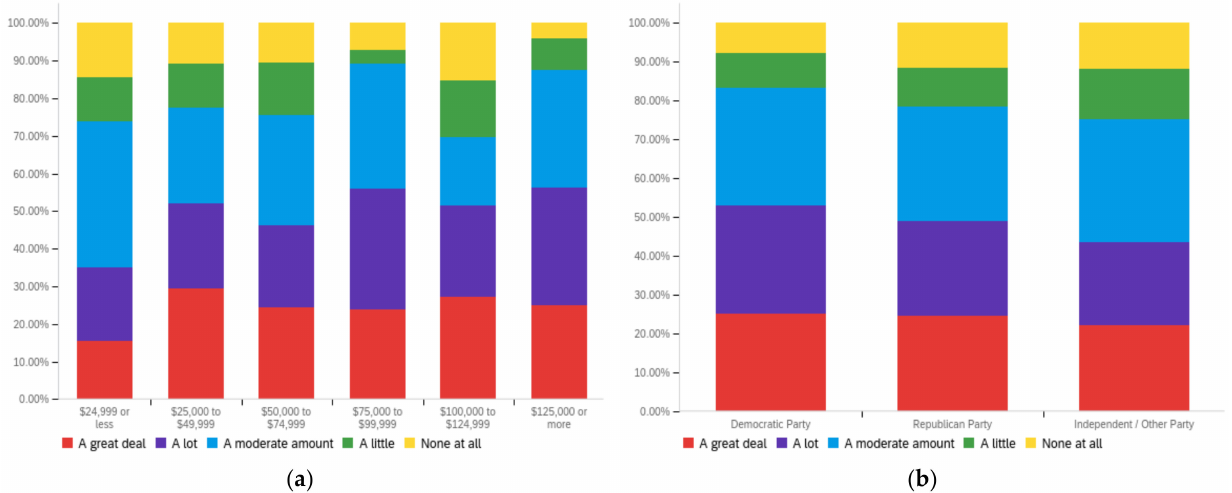
Figure A19. Cont